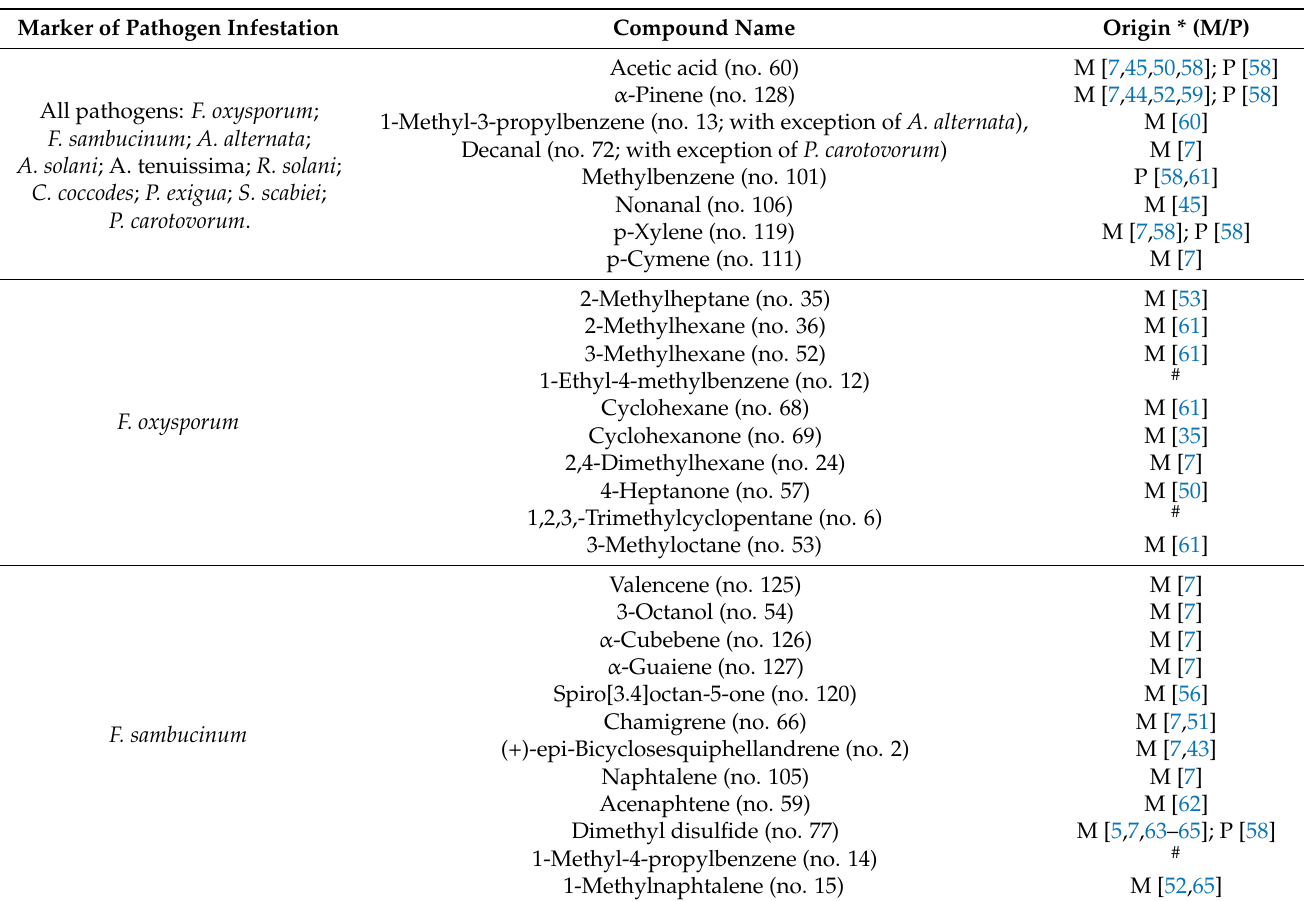
Table 3. Volatile compounds as markers of potato pathogens